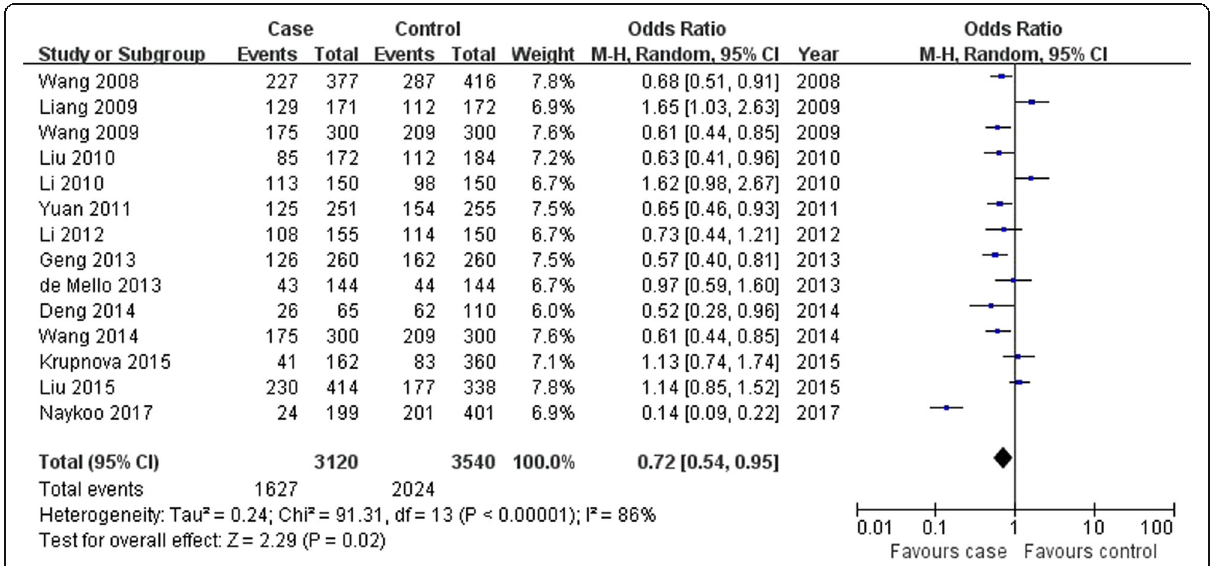
Fig. 4 Association between VEGF -2578C > A CC genotype and lung cancer susceptibility in overall populations